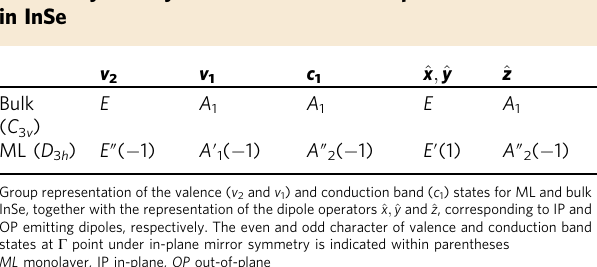
Table 1 Symmetry of states involved in optical transitions